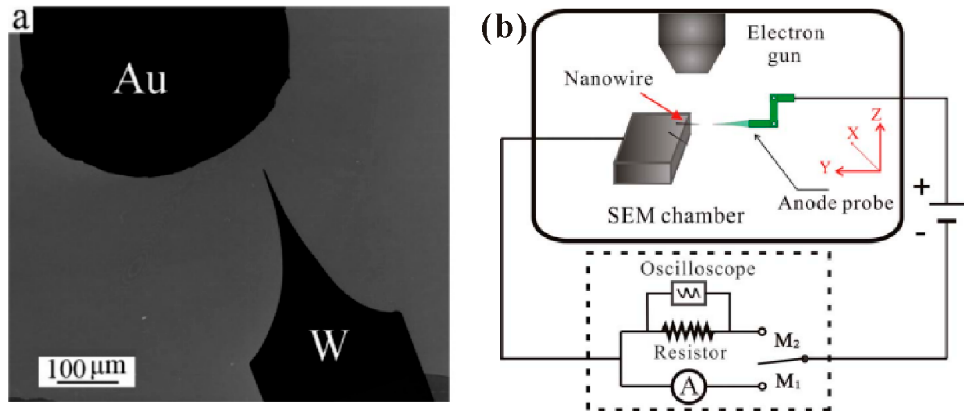
Figure 9. Single ZnO nanowire fabricated on platinum ( a , b ) and tungsten ( c – e ) probes. In ( a , c , d ), the nanowires were attached on the probe. While in ( b , e ), the nanowires were grown on the probe. ( a , b ) Reproduced from [62], with the per- mission of AIP Publishing, 2008. ( c , d ) Reproduced from [63], with the permission of ACS Publications, 2007. ( e ) Repro- duced from [64], with the permission of AIP Publishing, 2003.